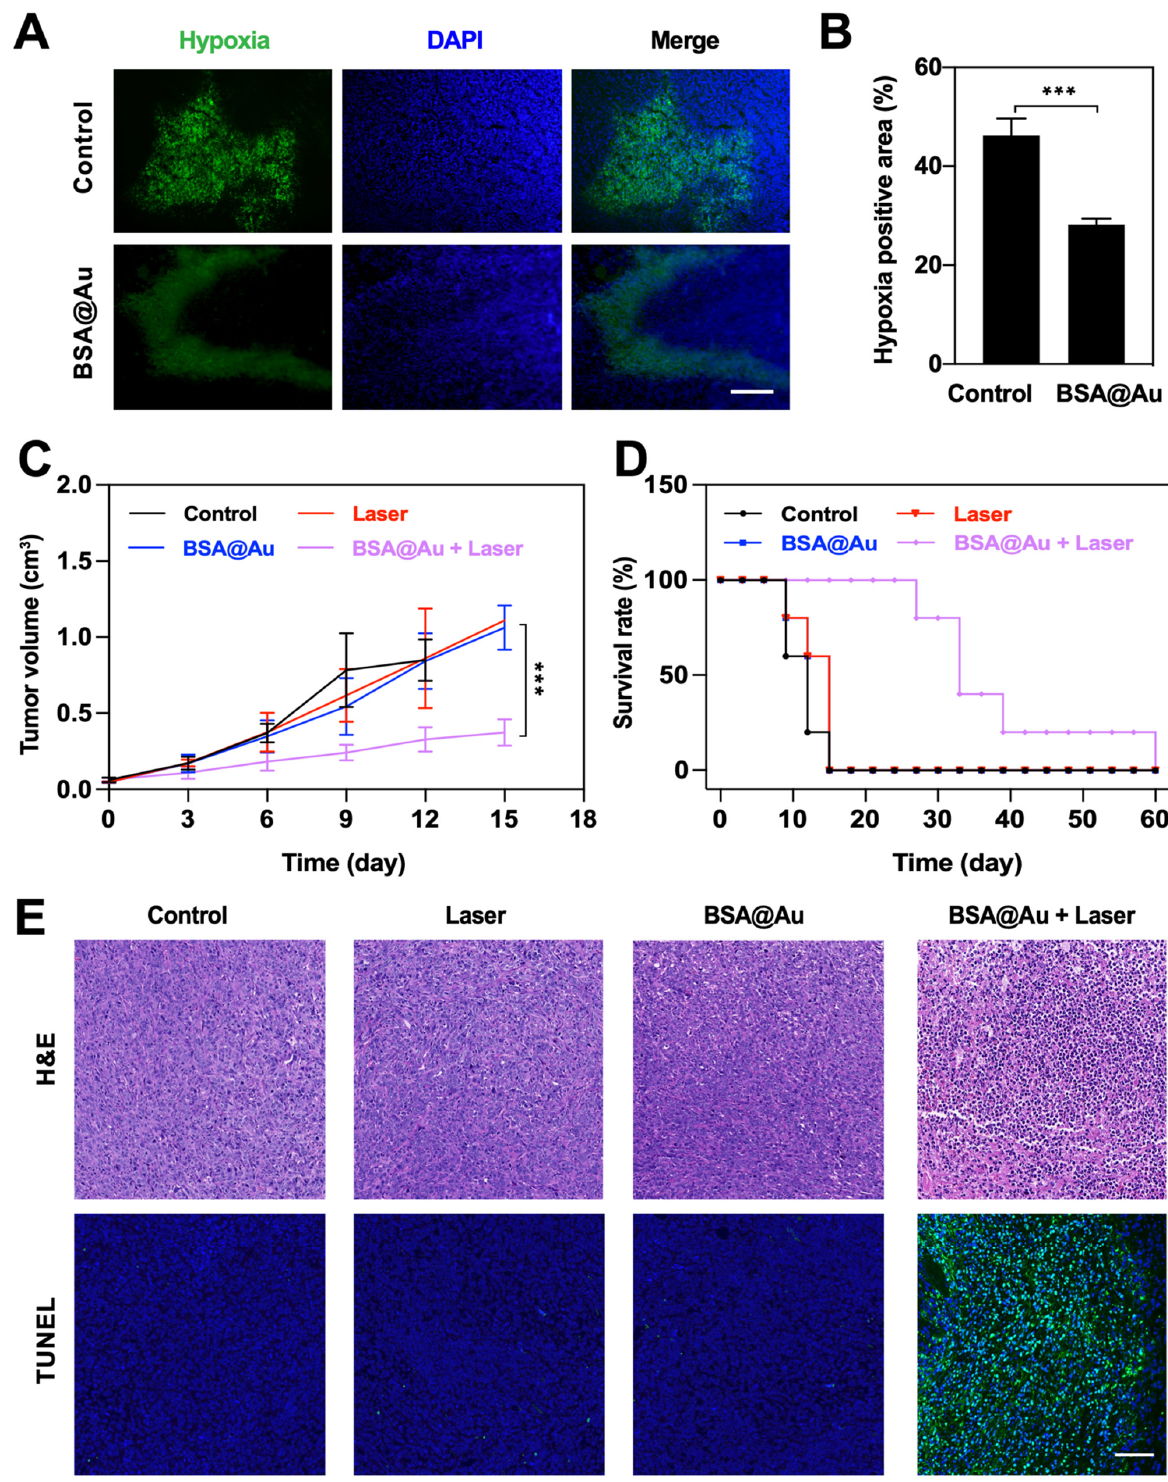
Figure 5. In vivo anti-tumor effect. ( A ) Representative immunofluorescence images of positive hypoxia area of tumor tissues after i.v. injection of PBS or BSA@Au. The scale bar was 100 µm. ( B ) The semi-quantification of positive hypoxia area shown in ( A ). ( C ) Tumor volumes variations over time after different treatments. ( D ) Survival rate of mice received different treatments. ( E ) H&E and TUNEL assay of tumor tissue sections from mice received different treatments. The scale bar was 100 µm. *** p < 0.005.